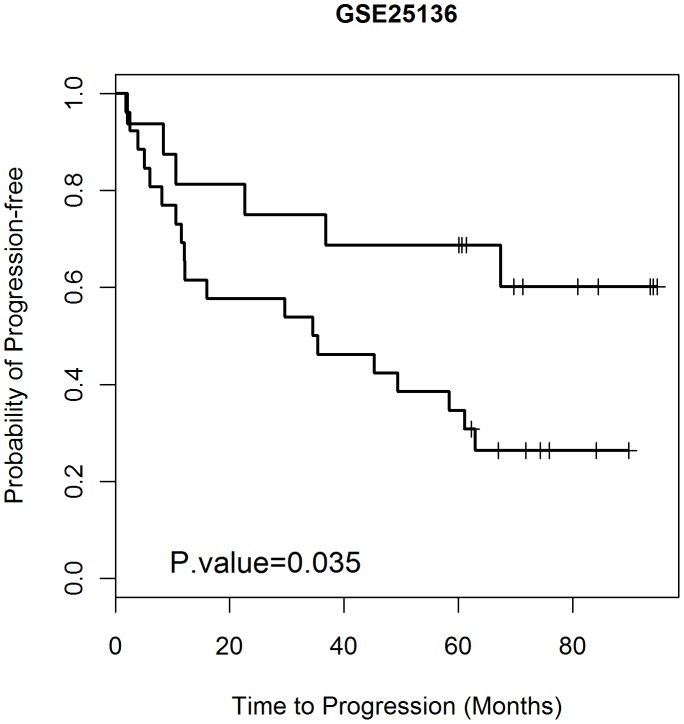
Survival analysis for the seven-gene Classifier.Kaplan-Meier estimates of survival time of 42 independent patients in Data Set 2 (GSE25136) according to the seven-gene Classifier.